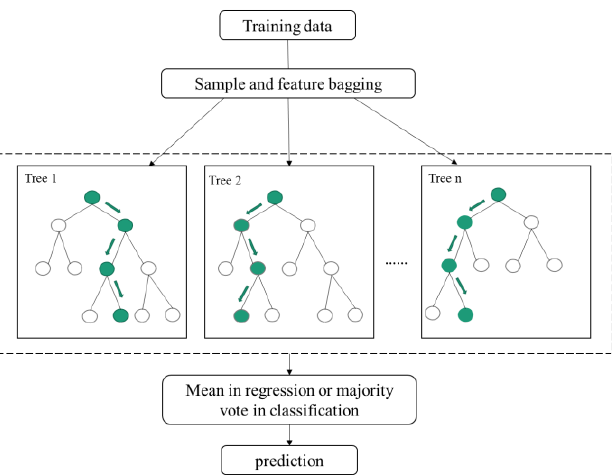
Figure 8. Model architectures of random forest classifier adopted in this study.